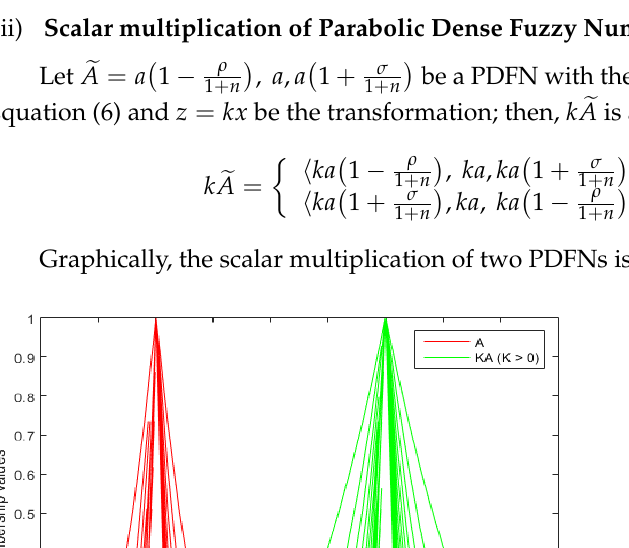
Figure 4. Subtraction of two parabolic dense fuzzy numbers.